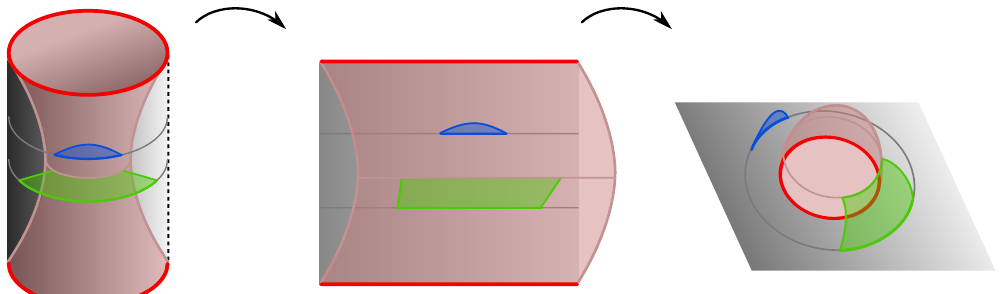
Figure 14 . BTZ black hole microstates have the same brane pro(cid:12)le and hence entanglement entropy as the planar black hole dual to a global quench. The quench geometry is obtained from a local conformal transformation of the excised disk, so the transition in entanglement entropy for the static case described above, and the BTZ microstates in [30], are controlled by the same CFT